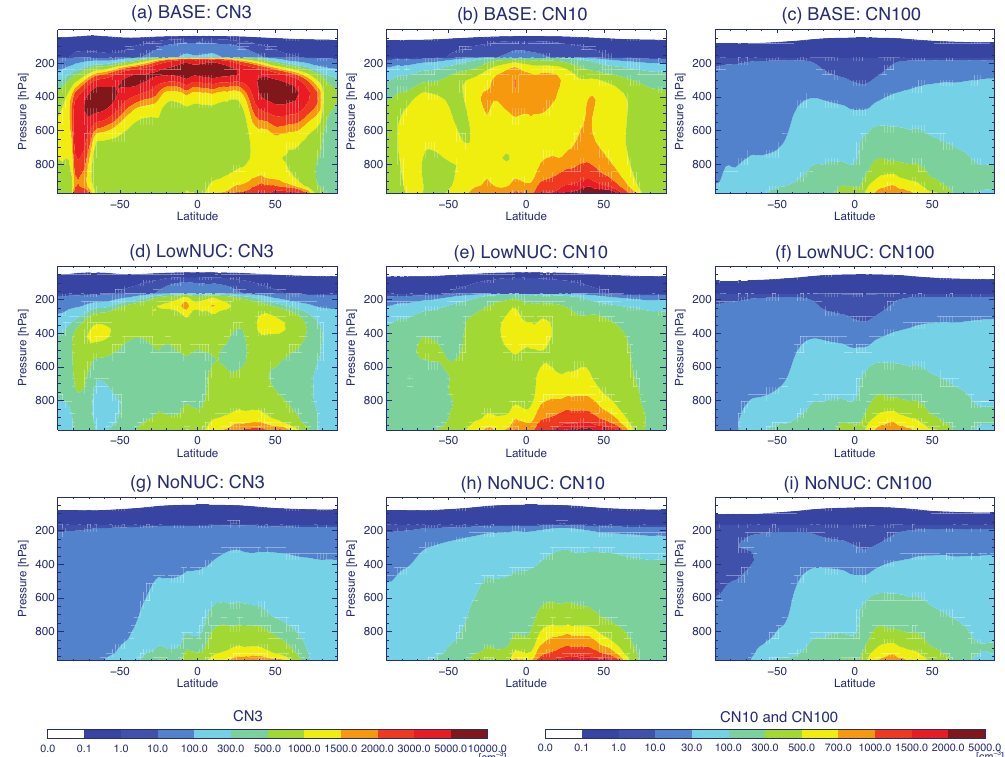
Figure 20. Annually and zonally averaged CN 3 (Dp ≥ 3nm), CN 10 (Dp ≥ 10nm), and CN 100 (Dp ≥ 100nm) concentrations for the BASE run ( a to c ), the LowNUC run ( d to f ), and the NoNUC run ( g to i ) of ModelE2-TOMAS. Units are cm − 3 .